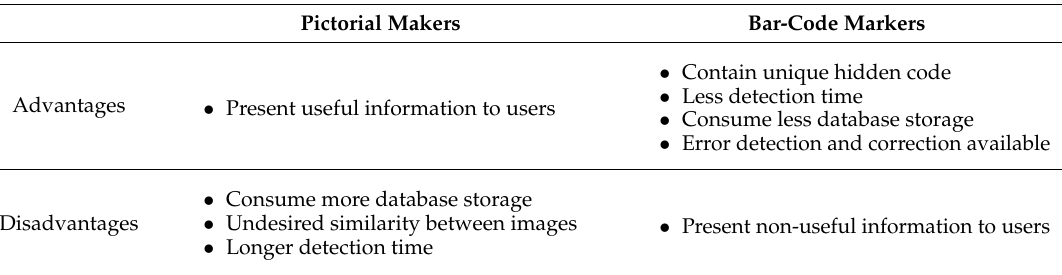
Table 1. Pictorial markers versus bar-code markers in augmented reality applications.